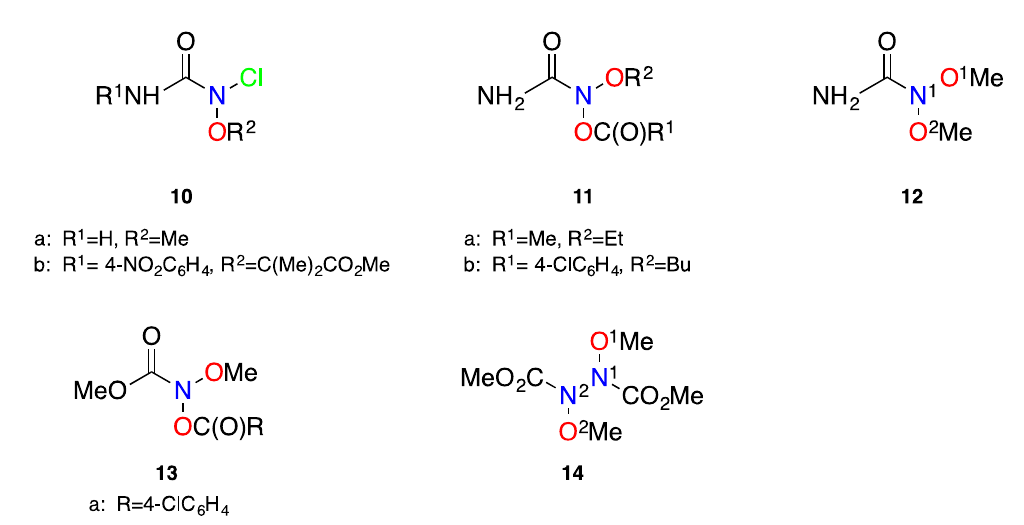
Table 2. Selected structural data for ureas 10 – 12 and carbamates 13 – 14 from X-ray structures. Structure